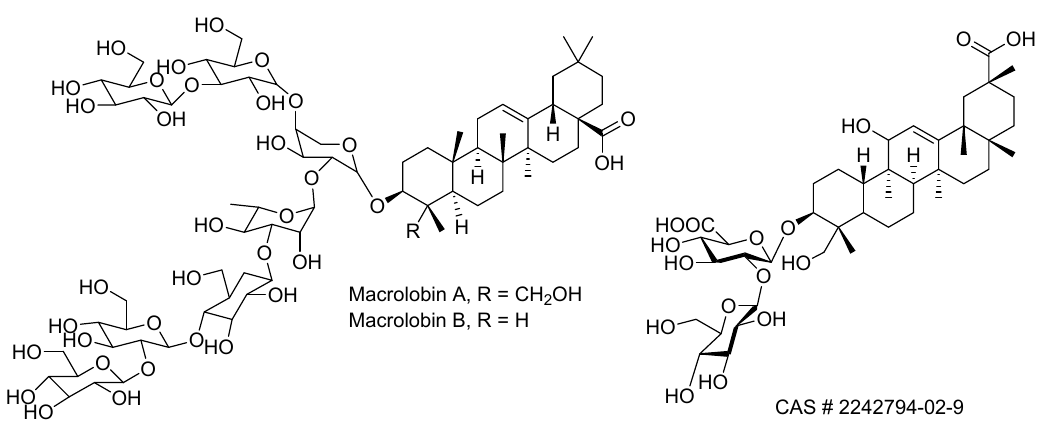
Figure 5. Selected saponins with antivenom activity .